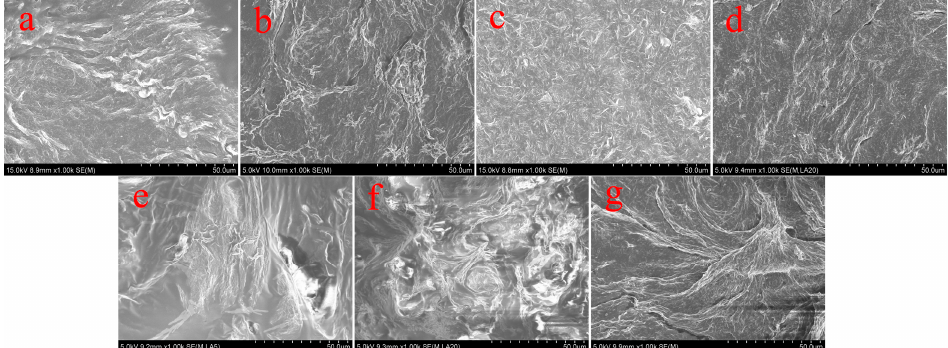
Figure 4. SEM images of TC16-Np xerogels from gels in various solvents: ( a ) DMF; ( b ) aniline;